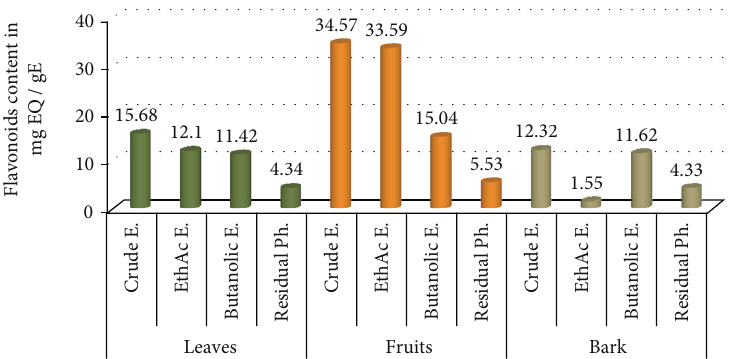
Figure 3: Flavonoids content of three organs from Pistacia atlantica Desf. in mg equivalent quercetin per gram of